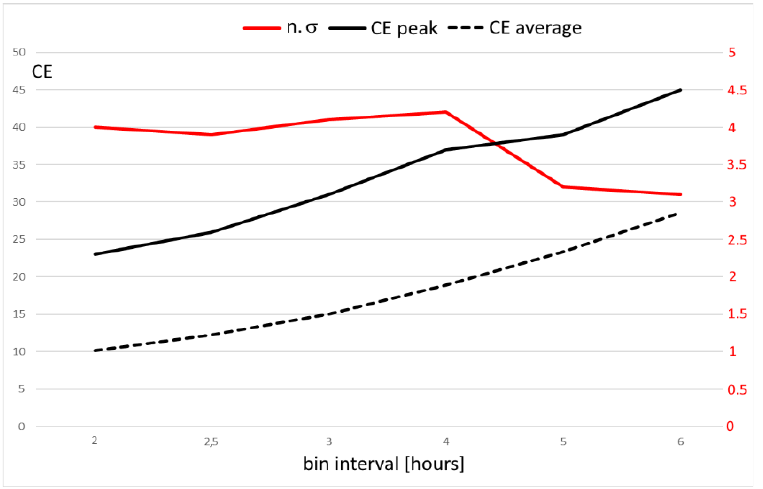
Figure 4. The correlation significance in red is compared with the correlation peaks in black and the corresponding correlation averages for the bin intervals reported in Figure 2.